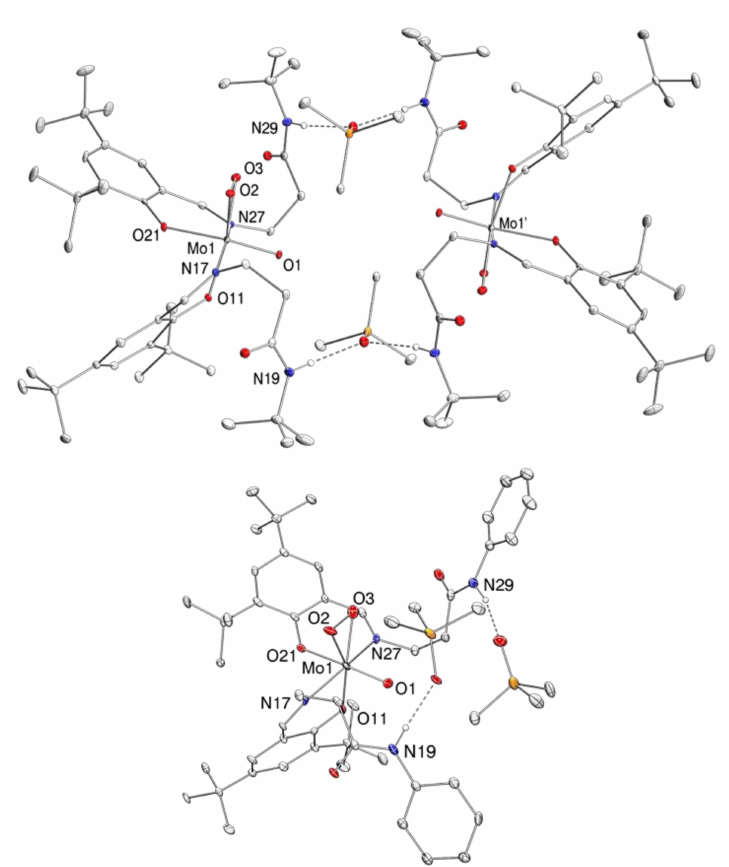
Figure 5. Molecular views (50% probability level) of the hydrogen bonds in the oxido peroxido complex adducts {[MoO(O 2 )( L2 ) 2 ] 2 (OPMe 3 ) 2 } ( 10 · OPMe 3 , top) and {[MoO(O 2 )( L3 ) 2 ](OPMe 3 ) 2 } ( 11 · 2OPMe 3 , bottom). H atoms, except amide protons, as well as solvent molecules are omitted for clarity reasons.